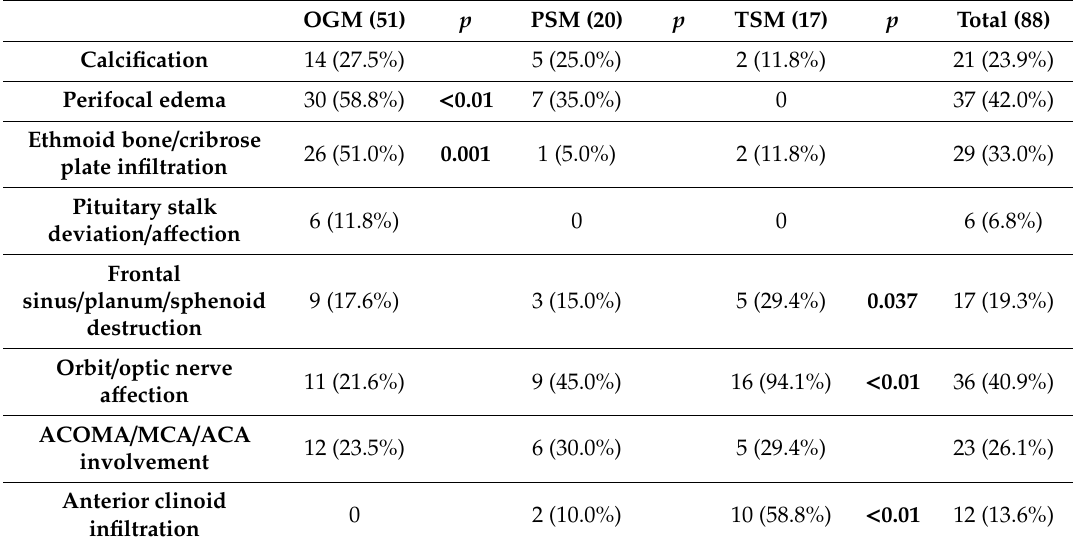
Table 2. Tumor characteristic and anterior skull base / neurovascular